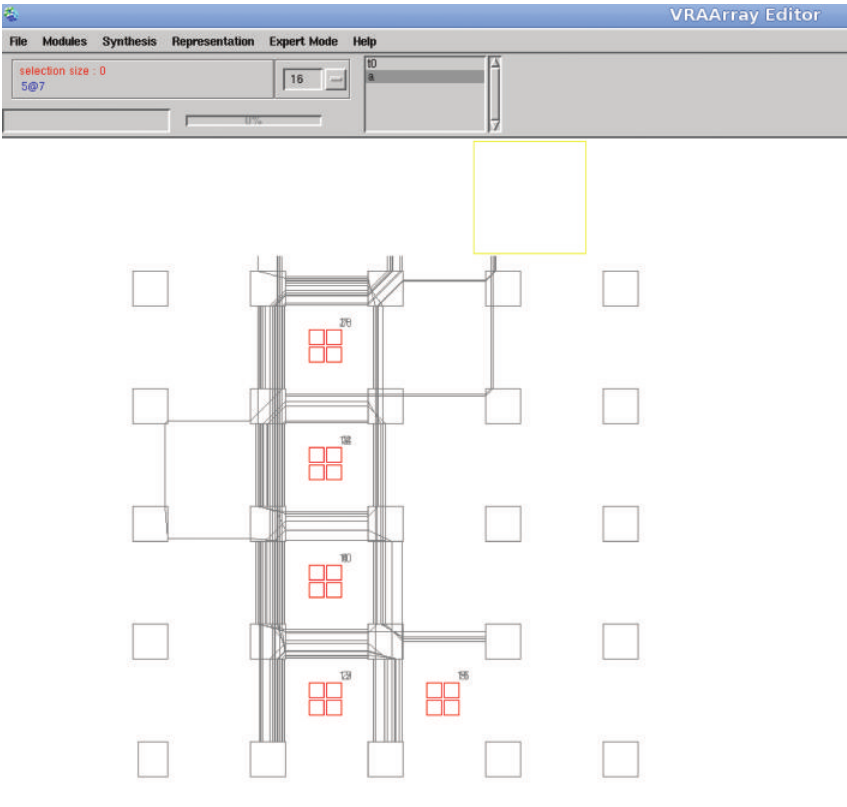
Figure 8: An application placed and routed over the RFU.